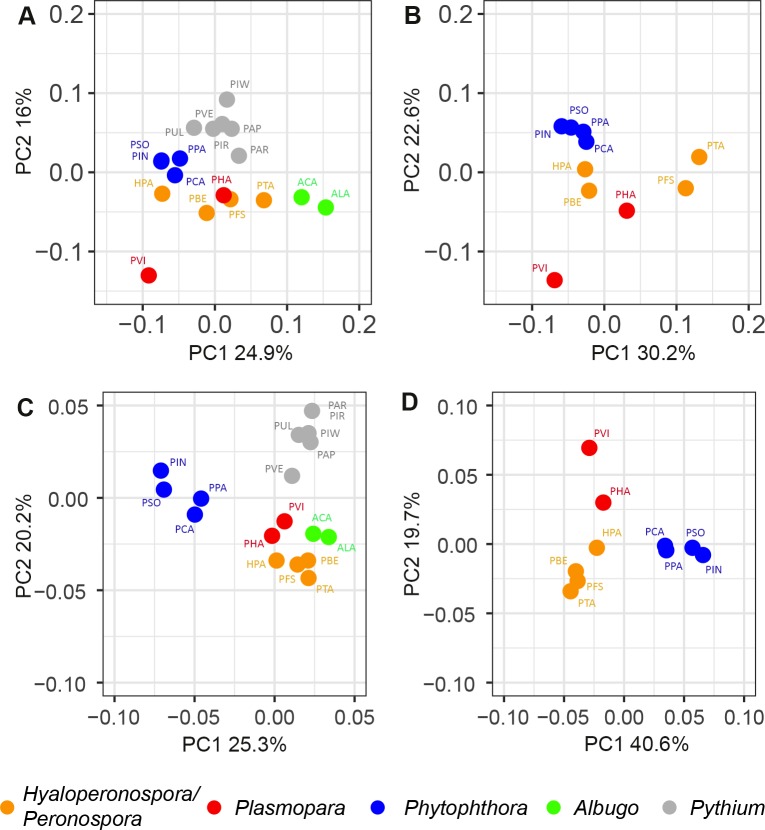
Principal component analysis (PCA) of variation in the relative abundance of secreted CAZymes and Pfam domains.The variation in secreted CAZyme (AB) and Pfam (CD) domains along PC1 and PC2 is depicted in the figure. The PCAs include all of the 18 species (AC) or the Peronospora, Plasmopara and Phytophthora species only (BD). The PERMANOVA test shows that the grouping based on the CAZyme and Pfam domains is significant (P < 0.001). Species are grouped by color based on the classes that were defined in the phylogenetic tree (Fig 5). Phytophthora (blue), Peronospora (yellow), Plasmopara (red), Albugo (green) and Pythium (grey). Abbr. PFS; Peronospora (P.) effusa, PBE; P. belbahrii, PTA; P. tabacina, HPA, Hyaloperonospora arabidopsidis, PHA; Plasmopara (Pl.) halstedii, PVI; Pl. vitiocola, PIN; Phytophthora (Ph.) infestans, PSO; Ph. sojae, PCA; Ph. capsici, PPA; Ph. parasitica, ACA; Albugo (A) candida, ALA; A. laibachii, PUL; Pythium (Py.) ultimum, PAR; Py. arrhenomanes, PAP; Py. Aphanidermatum, PIR; Py. irregulare, PIW; Py. Iawyamai, PVE; Phytopythium vexans.